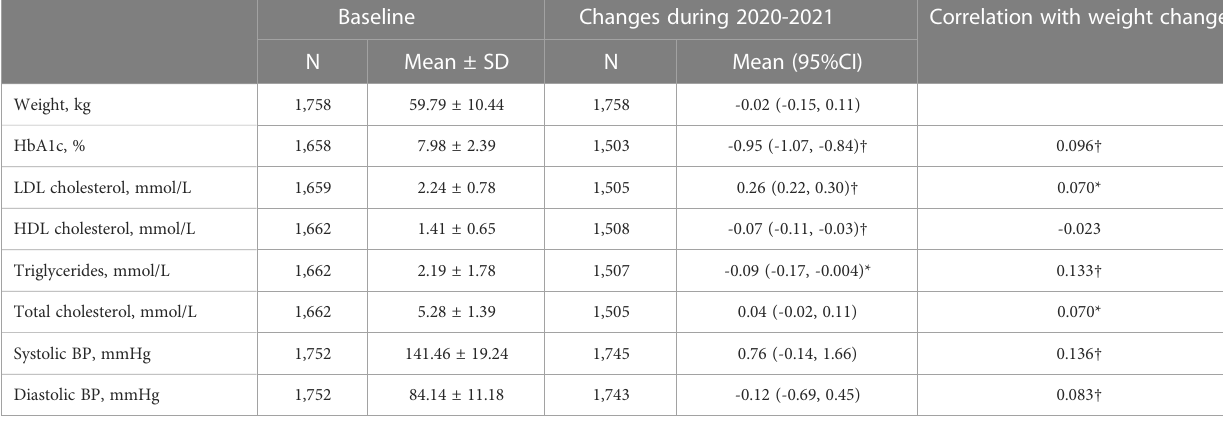
TABLE 3 Changes in CV risk factors and their correlations with weight change.